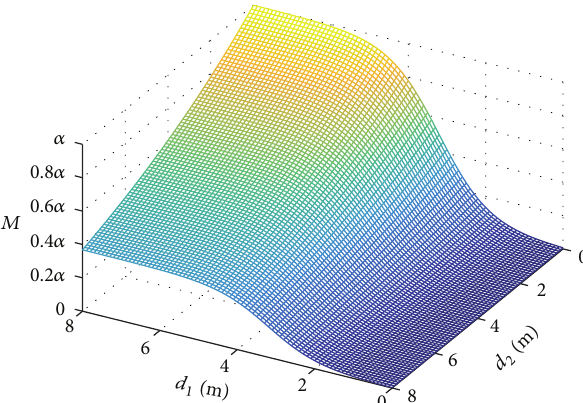
Figure 4: The curve of the subconscious strength 𝑀 for RP.